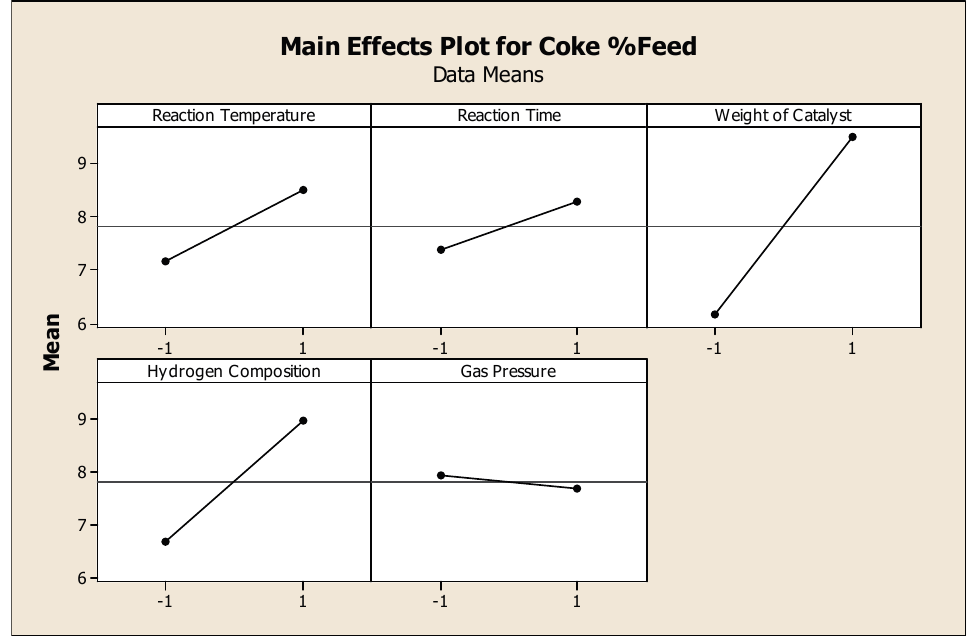
Figure 3. Main effect plot for C16 fatty acid, unreacted triglyceride (TG) oil.